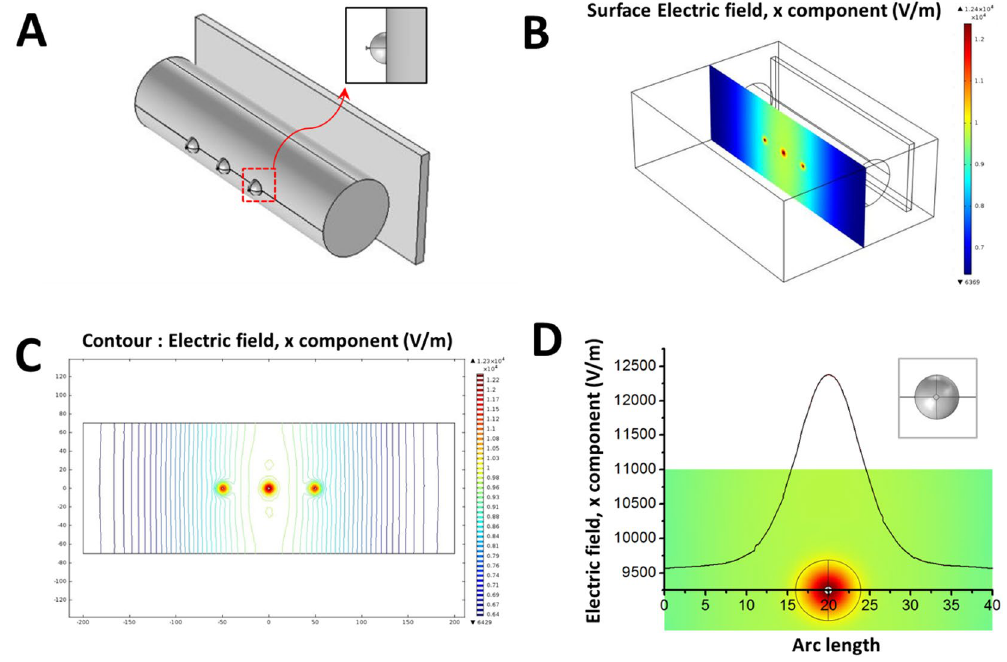
Figure 3. ( A ) Setup of the fabrication of the 3D nanofibrous scaffolds with radially aligned patterns ( B ) result of the electric field distribution simulation (front view): surface of electric field ( C ) contour ( D ) distance variation of electric field intensity (front view): horizontal